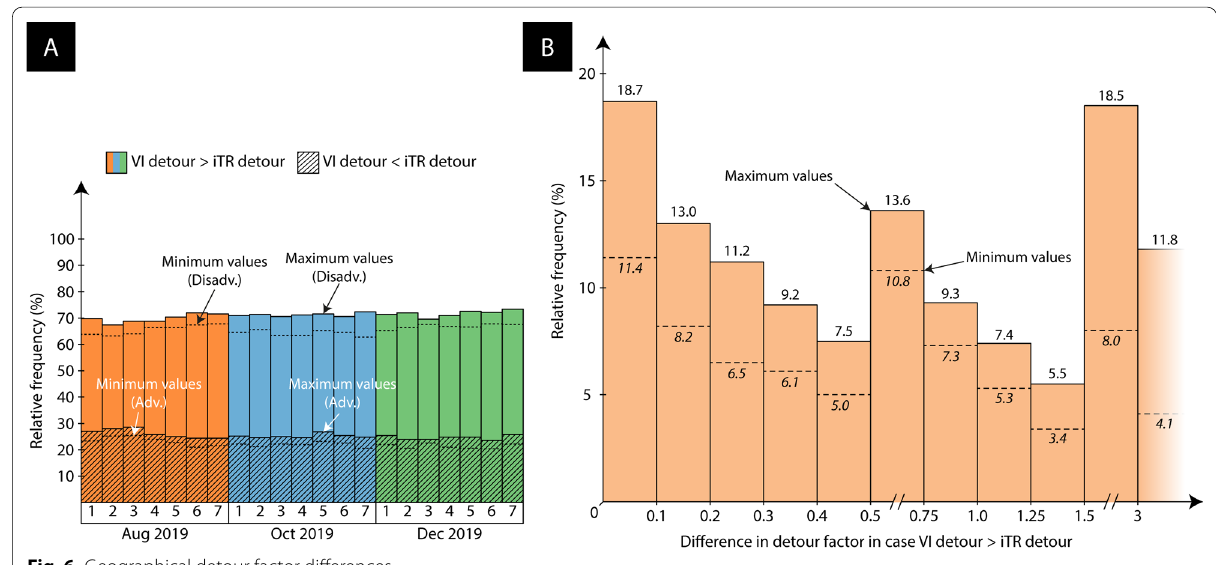
Fig. 6 Geographical detour factor